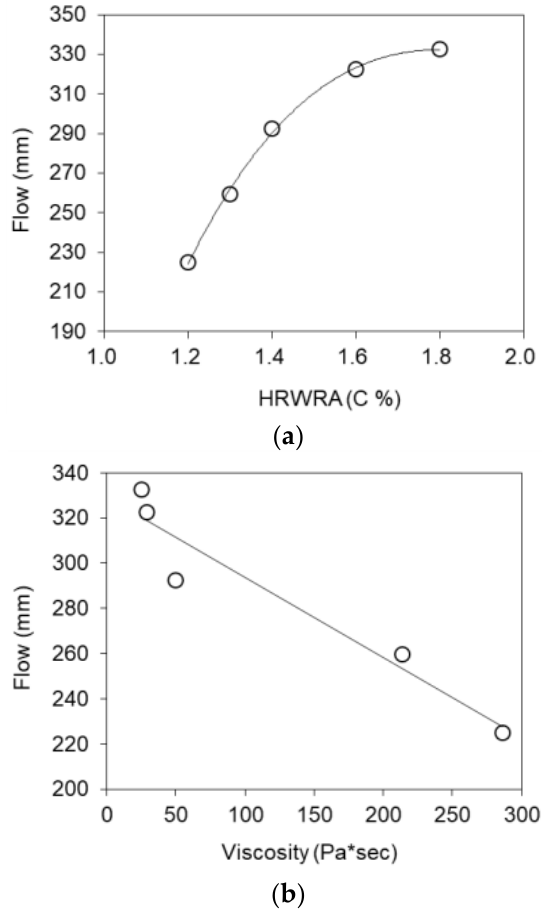
Figure 24. Flow of UHPFRC. ( a ) HRWRA — mortar flow. ( b ) Viscosity — flow.